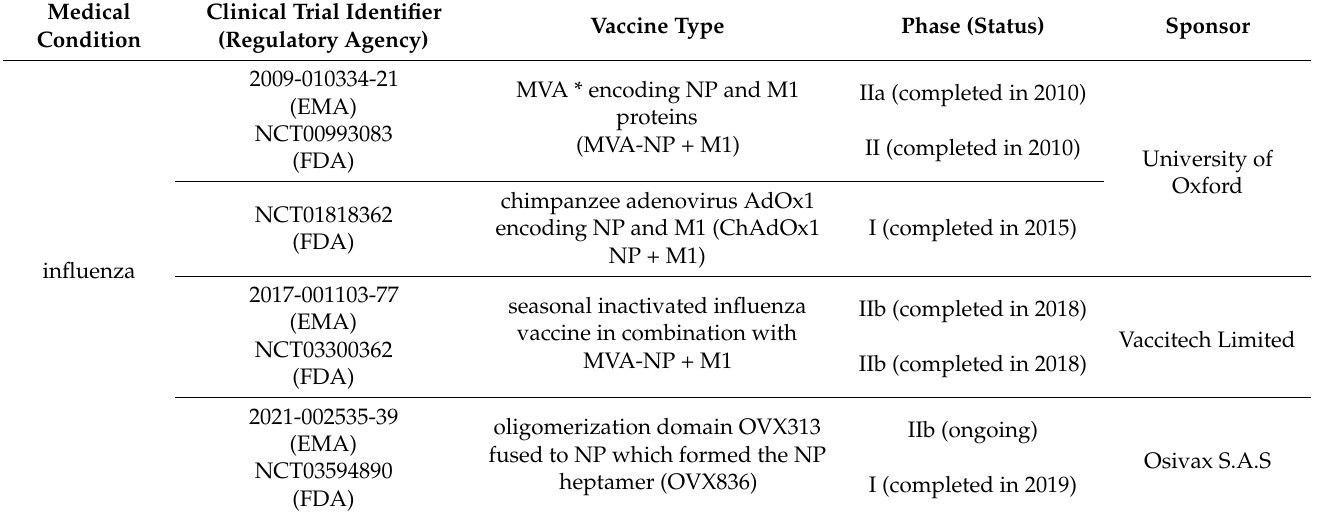
Table 4. Clinical trials for novel vaccines based on the NP against human NSVs in Phases 1–3 listed by the FDA (https://www.clinicaltrials.gov, accessed on 1 February 2022) or EMA